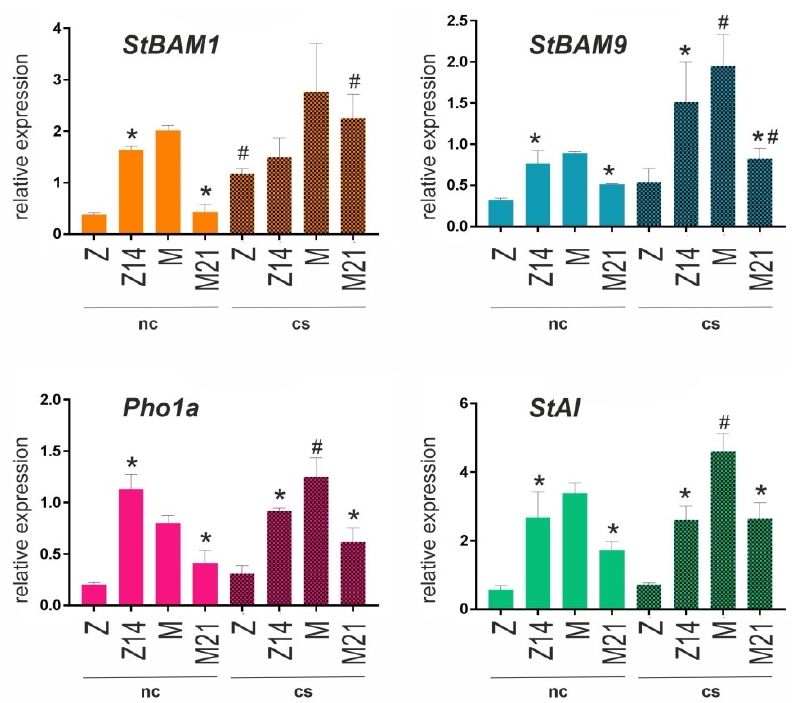
Figure 4. Expression of the StBAM1 , StBAM9 , PHO1a , and StAI genes in the roots of potato cultivars Zhukovskii rannii (Z) and Mishka (M) and transgenic Z14 and M21 lines at normal growth conditions (+21 ◦ C; nc) and in response to cold stress (+4 ◦ C for 3 days; cs). The data were normalized to ELF1 and SEC3A mRNA levels and presented as the mean ± SD ( n = 3); * p < 0.01—transgenic vs. wild-type plants; # p < 0.01—cold stress vs. normal